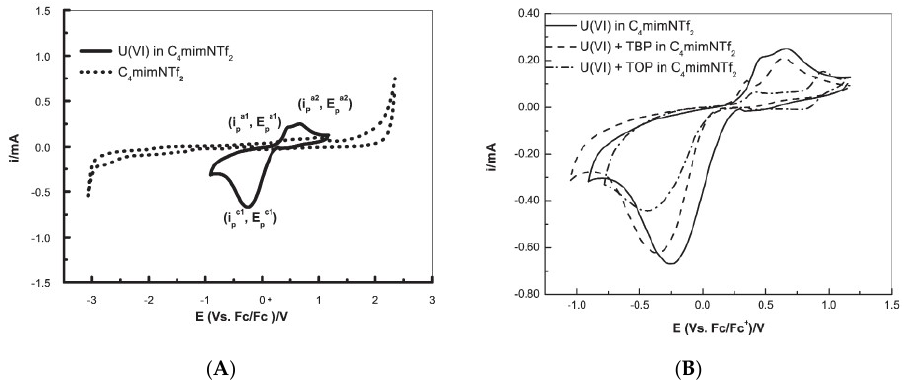
Figure 7. Cyclic voltammograms recorded at a glassy carbon electrode ([U(VI)] = 100 mM, scan rate